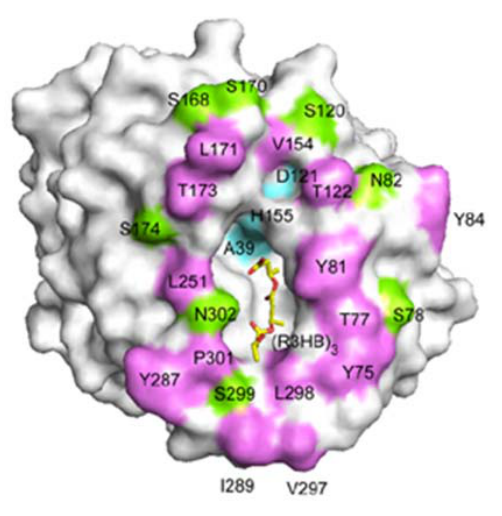
Figure 15. A molecular surface representation of the PHA depolymerase from P . funiculosum centering on the mouth of the crevice. Positions of solvent-exposed hydrophobic residues (purple), as well as polar (green) and catalytic triad (cyan) residues, are indicated. A model of the 3HB trimer bound in the crevice is shown as a yellow stick model [86]. Reproduced with permission from Hisano et al. , J. Mol. Biol .; published